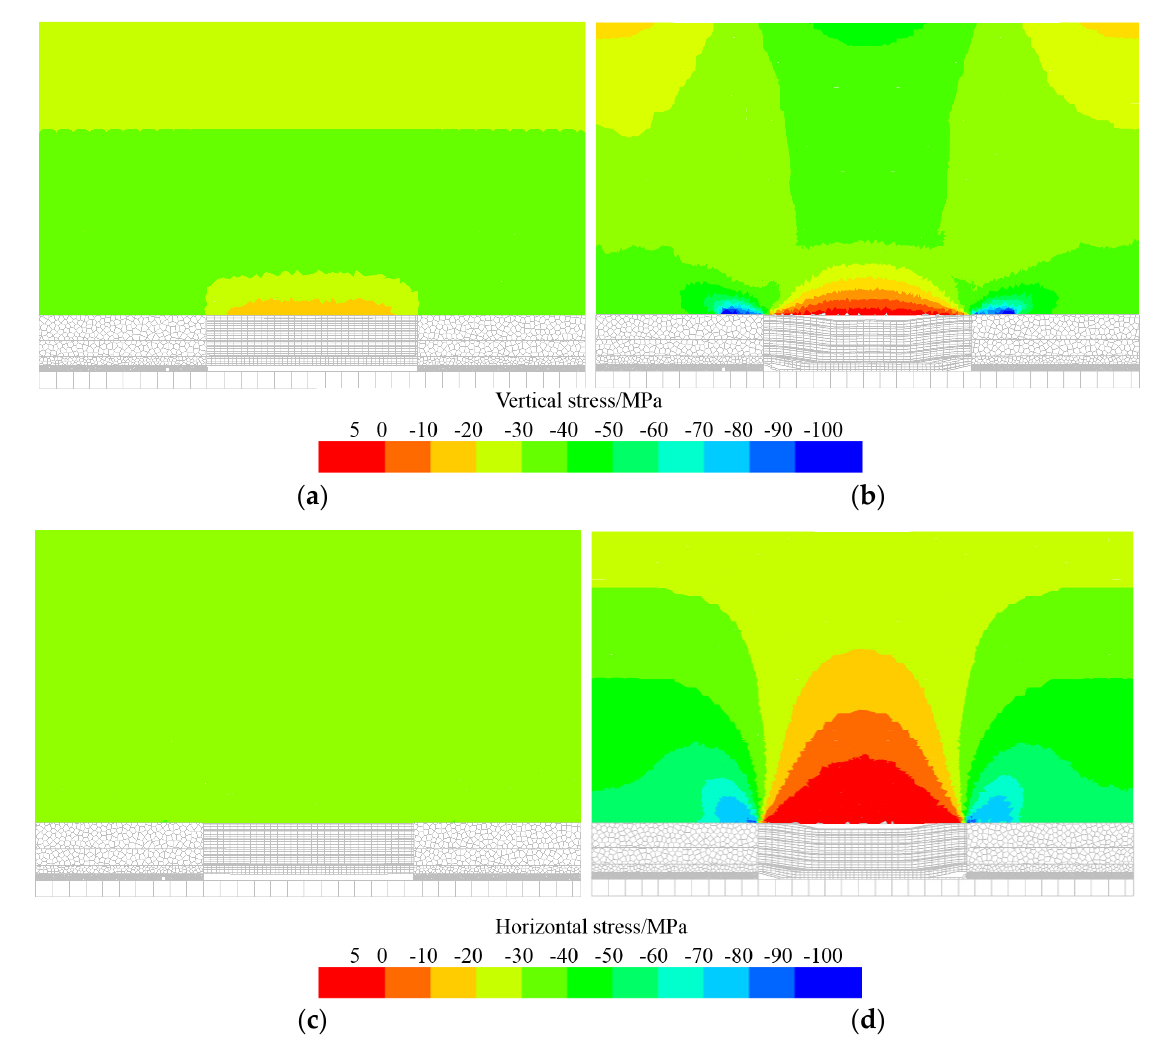
Figure 2. Stress distribution of overlying strata before and after goaf formation: ( a ) Vertical stress before goaf formation; ( b ) Vertical stress after goaf formation; ( c ) Horizontal stress before goaf formation; ( d ) Horizontal stress after goaf formation.